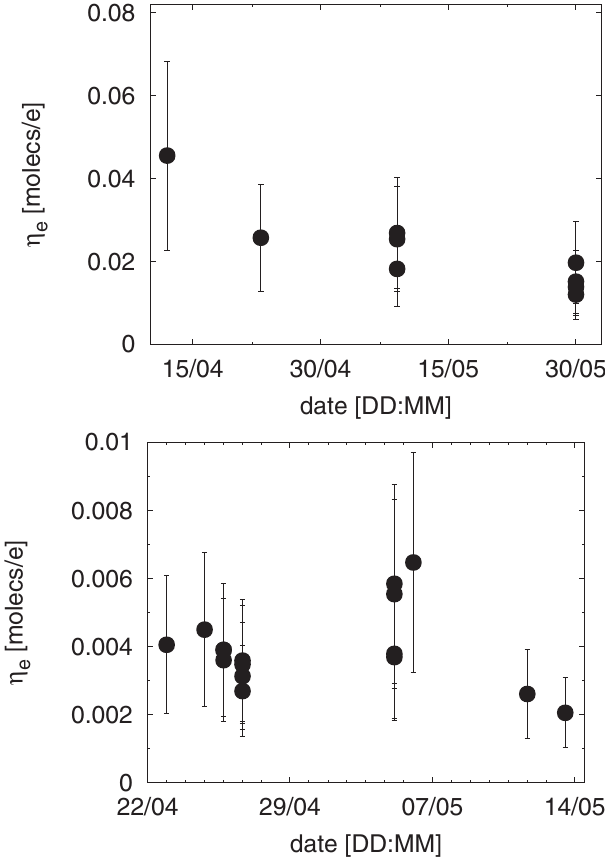
FIG. 12. Calculated desorption coefficients for the unbaked stainless steel surface BO2 (top), and the baked stainless steel surface at IR12. The error bar (50%) stems from the systematic uncertainty in the pumping speed and vacuum pressure readings. A decrease of the desorption coefficient with time is noticeable for the unbaked stainless steel (top) due to the scrubbing effect